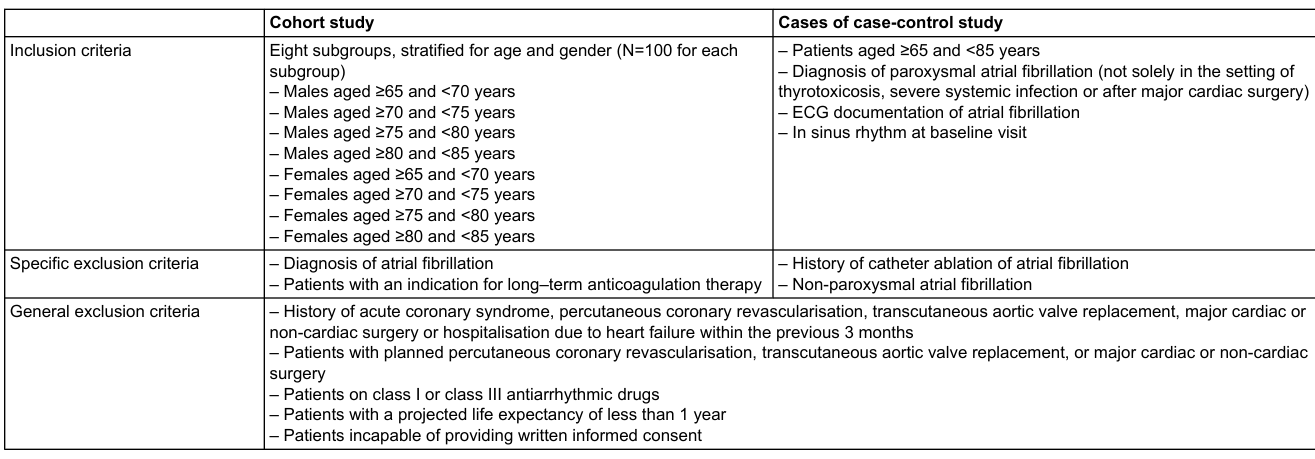
Table 1: Overview of inclusion and exclusion